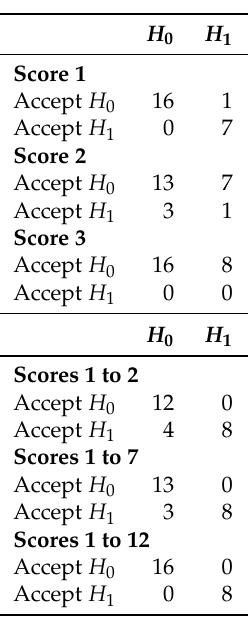
Table 5. Categorization of the samples with respect to the presence or absence of a fault and the result of the test considering the first score, the second score, the third score (left); and scores 1 to 2 (jointly), scores 1 to 7 (jointly), and scores 1 to 12 (jointly) (right), when ν = 50 and α =